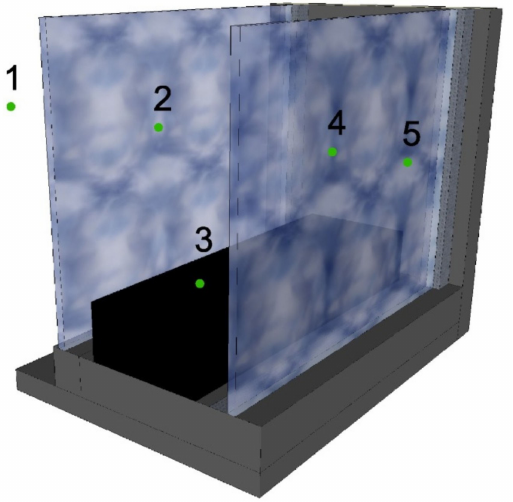
Figure 2. Diagram of the numerical model used; 1 outside air; 2-inner surface of the outer glazing unit; 3-heat accumulator with phase change material; 4- inner surface of the internal glazing unit; 5-indoor